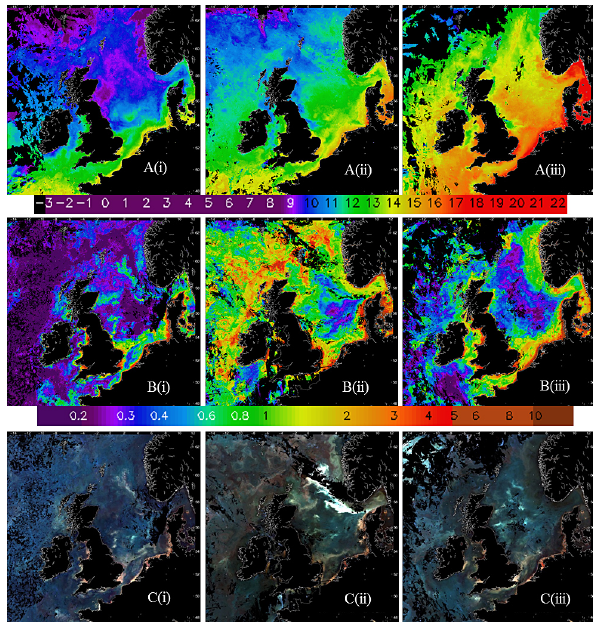
Figure 2. Earth observation 7-day composite images of sea-surface temperature ( a ◦ C), chlorophyll concentration ( b mgm − 3 ) and enhanced-colour (c) starting from Julian days 146 (26 May (i)), 163 (12 June (ii)) and 190 (9 July